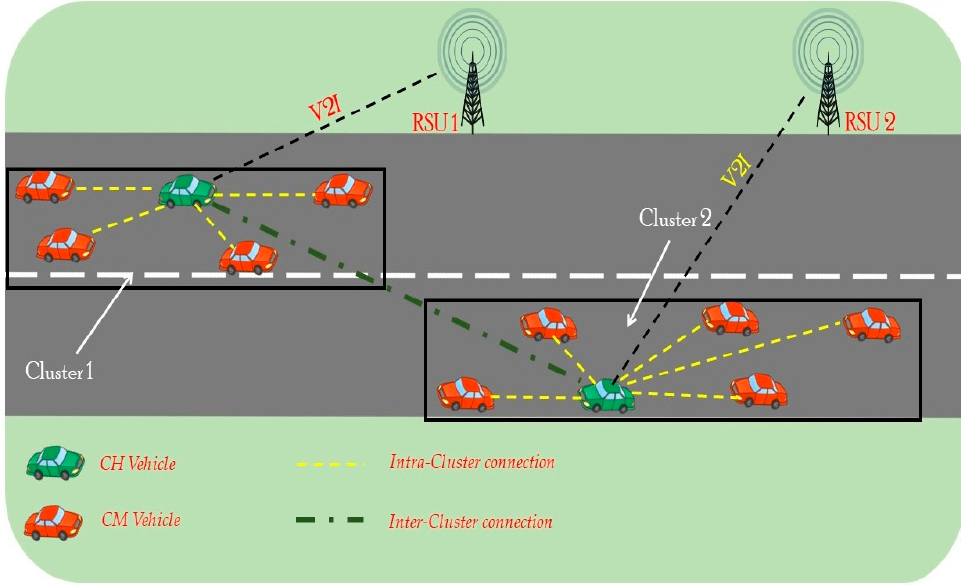
Figure 1. VANET clustering scheme.